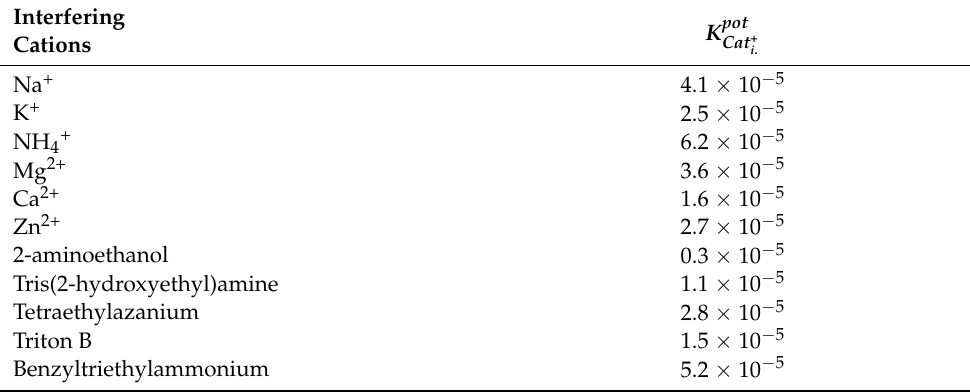
Table 2. Calculated selectivity coefficient for different inorganic and organic anions mostly used in commercially formulated products measured with the DHBI–TPB surfactant